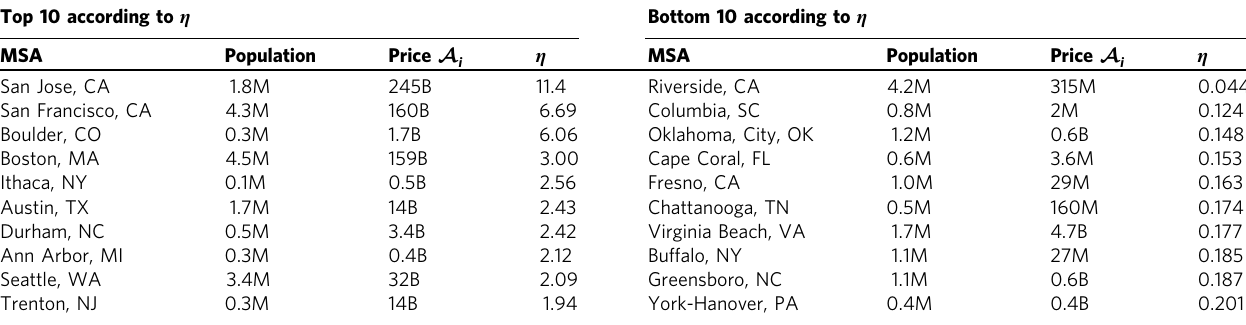
Table 1 Cumulative acquisition prices A i for the ten metropolitan areas (MSAs) with the highest values of centrality/population ratio η , and the ten cities with the lowest